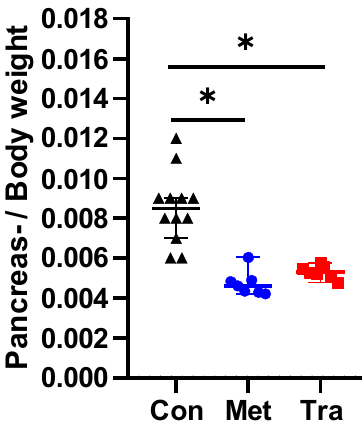
Figure 4. Pancreas weight to body weight ratio without and after chronic pancreatitis. The pancreas weight to body weight ratio of healthy mice (Con, black triangles) was significantly higher than the ratio observed in mice, which su ff ered from chronic pancreatitis and drank metamizole (Met, blue circles) or tramadol (Tra, red squares). No significant di ff erence between the metamizole- and tramadol-treated animals was observed. * p ≤ 0.05 (one-way ANOVA with Sidak’s correction for multiple comparisons). Healthy mice: n = 12, metamizole: n = 7; tramadol: n =